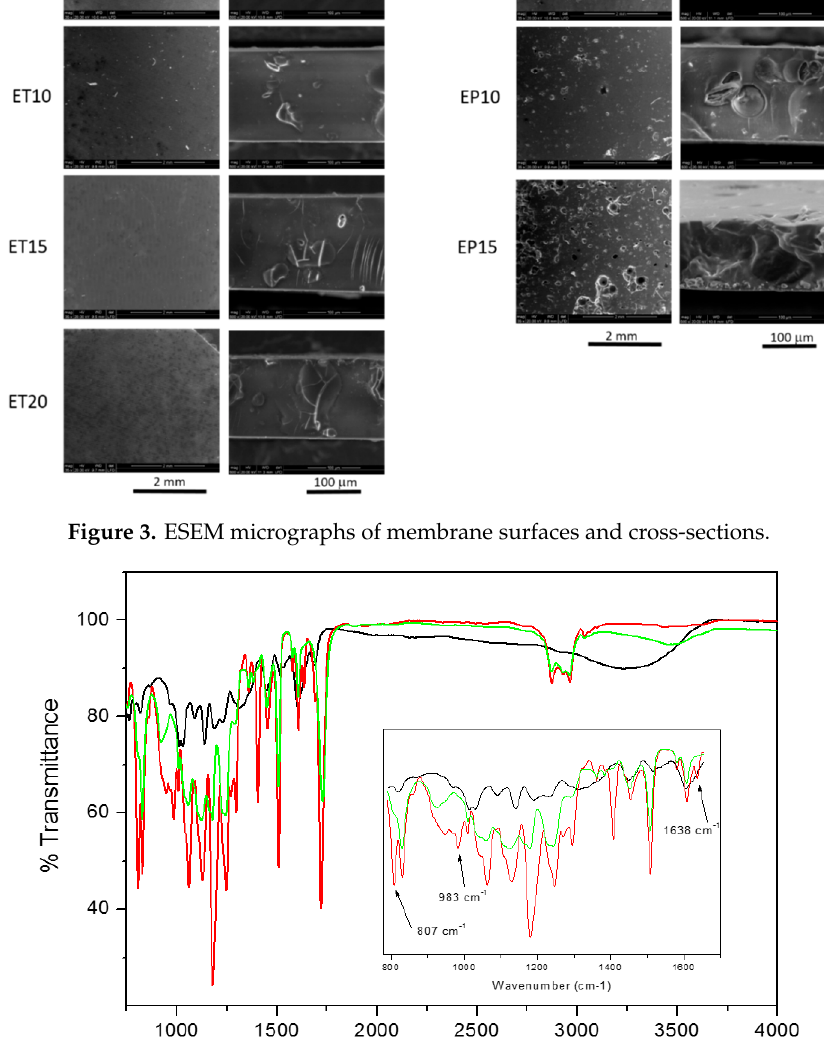
Figure 4. FTIR spectra of tea powder (black line), ET10 before UV-curing (red line) and ET10 UV-cured (green line). In the inset, the 790–1650 cm − 1 region is zoomed.